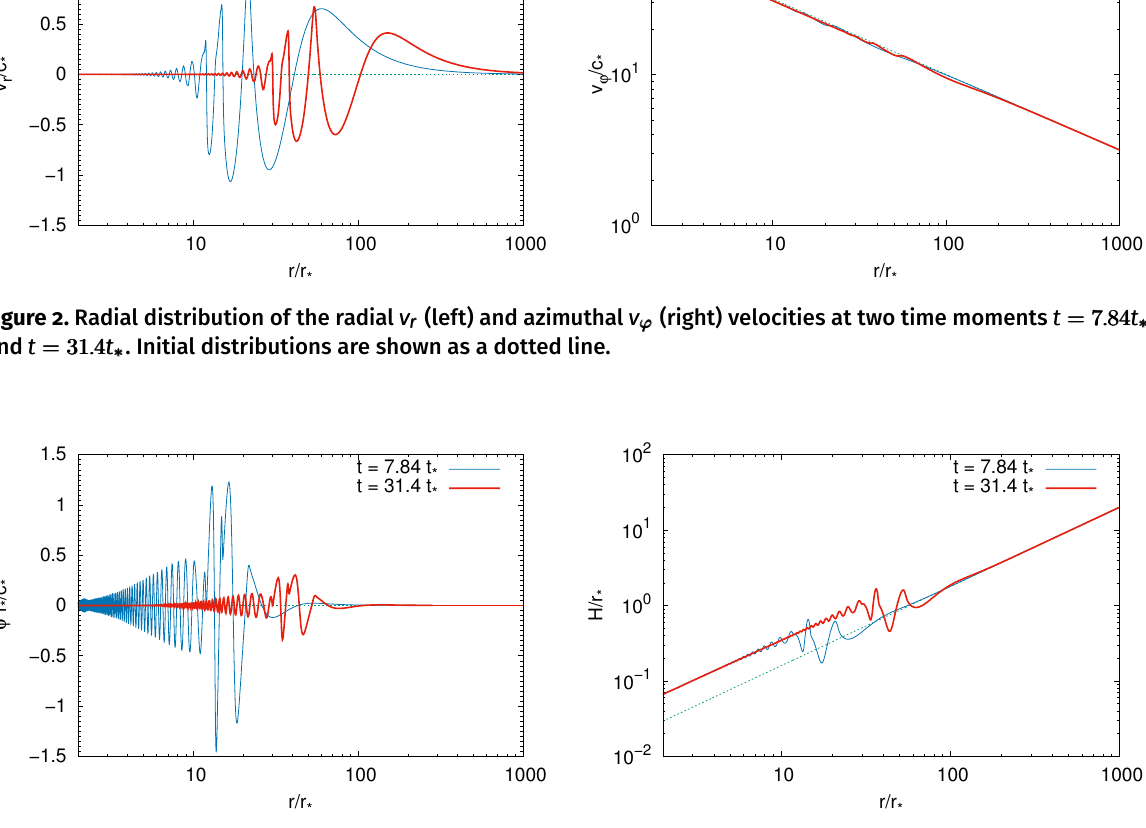
Figure 3. Radial distribution of the coefficient ψψψ (left) and the half-thickness of the disk H (right) at two time moments t = 7 . 84 t ∗ t = 7 . 84 t ∗ t = 7 . 84 t ∗ and t = 31 . 4 t ∗ t = 31 . 4 t ∗ t = 31 . 4 t ∗ . Initial distributions are shown as a dotted line.